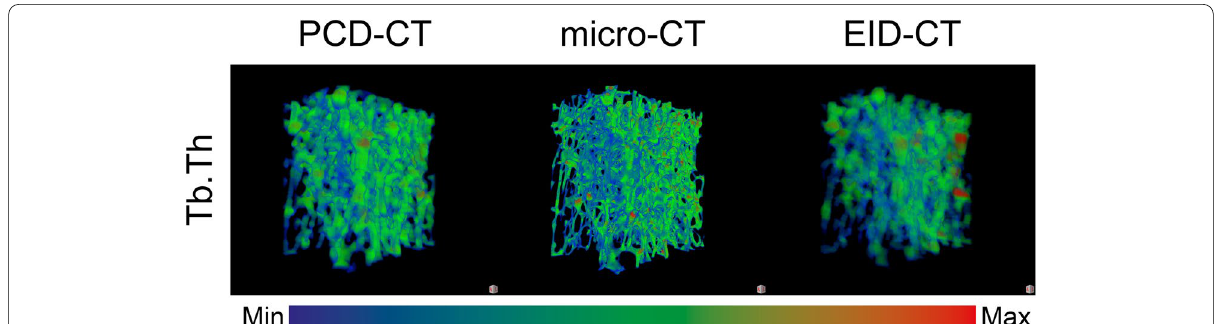
Fig. 3 Three-dimensional map of trabecular thickness (Tb.Th) within one of the analysed specimens. For the multislice computed tomography using photon-counting detectors (PCD-CT), the combination of a field of view of 51 mm and a matrix of 1,024 multislice computed tomography using energy-integrating detectors (EID-CT) the mAs setting with the same CTDIvol as the PCD-CT was used. The colour scale was adjusted so that the minimum and maximum values for each modality were represented by pure blue and red, respectively, with the midpoint between them being represented by pure green. Micro-CT Micro-computed tomography